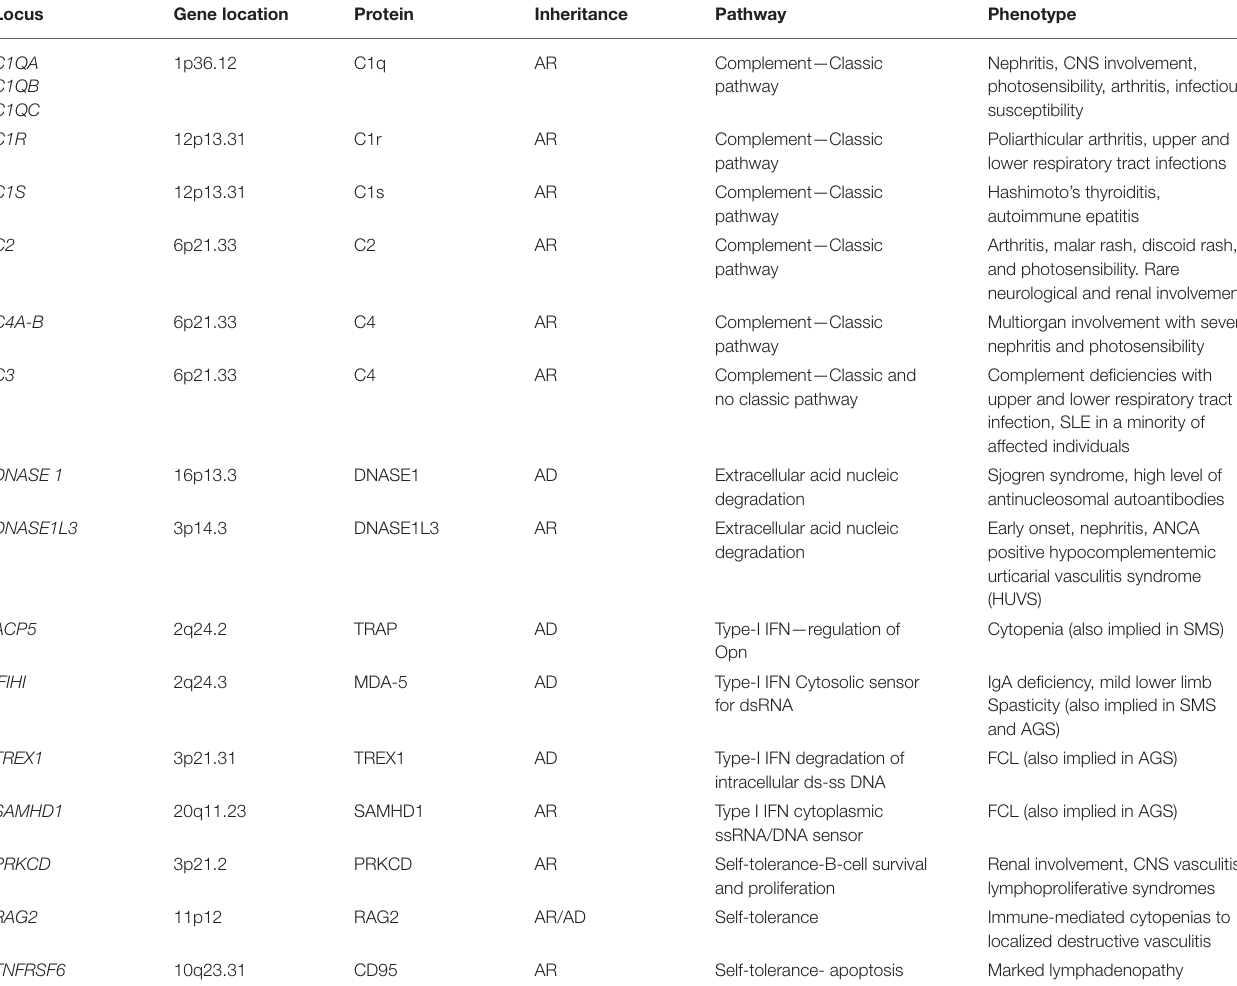
TABLE 2 | The main altered genes described in the monogenic forms of SLE and corresponding phenotype. Locus Gene location